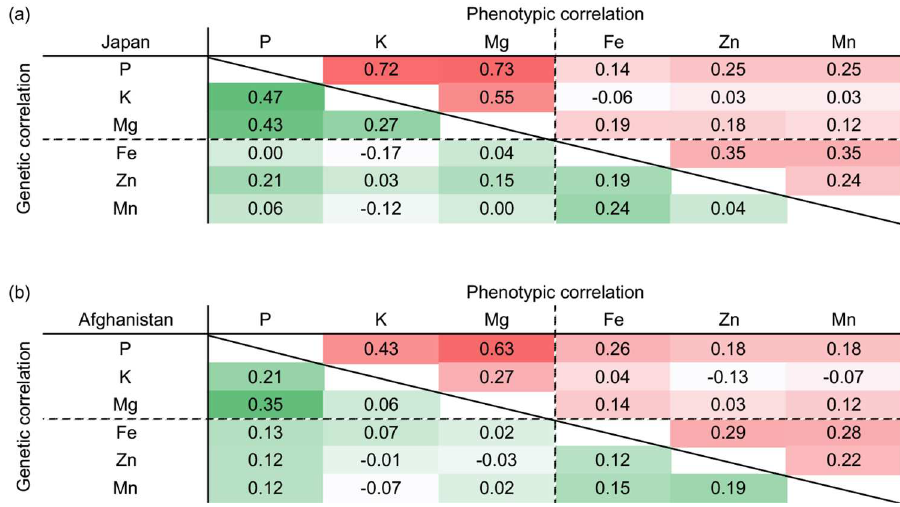
Fig 3. Phenotypic and genetic correlations among elements in Japan (a) and Afghanistan (b). The degreeof phenotypic and genetic correlationsare indicatedby red and green color scale intensities,